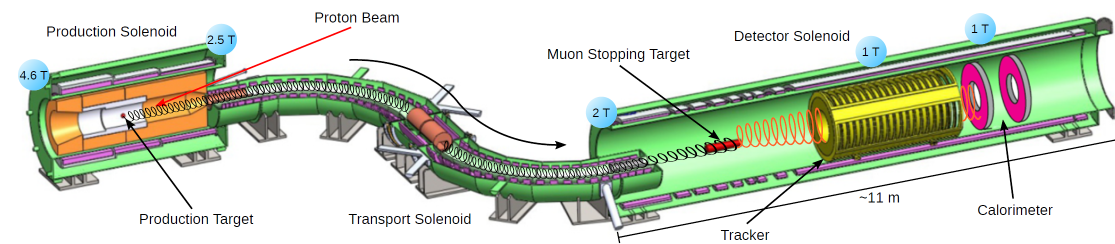
Figure 4: The Mu2e experiment in a cut away view, that highlights the internal components. Figure 3. Layout of the Mu2e experiment.